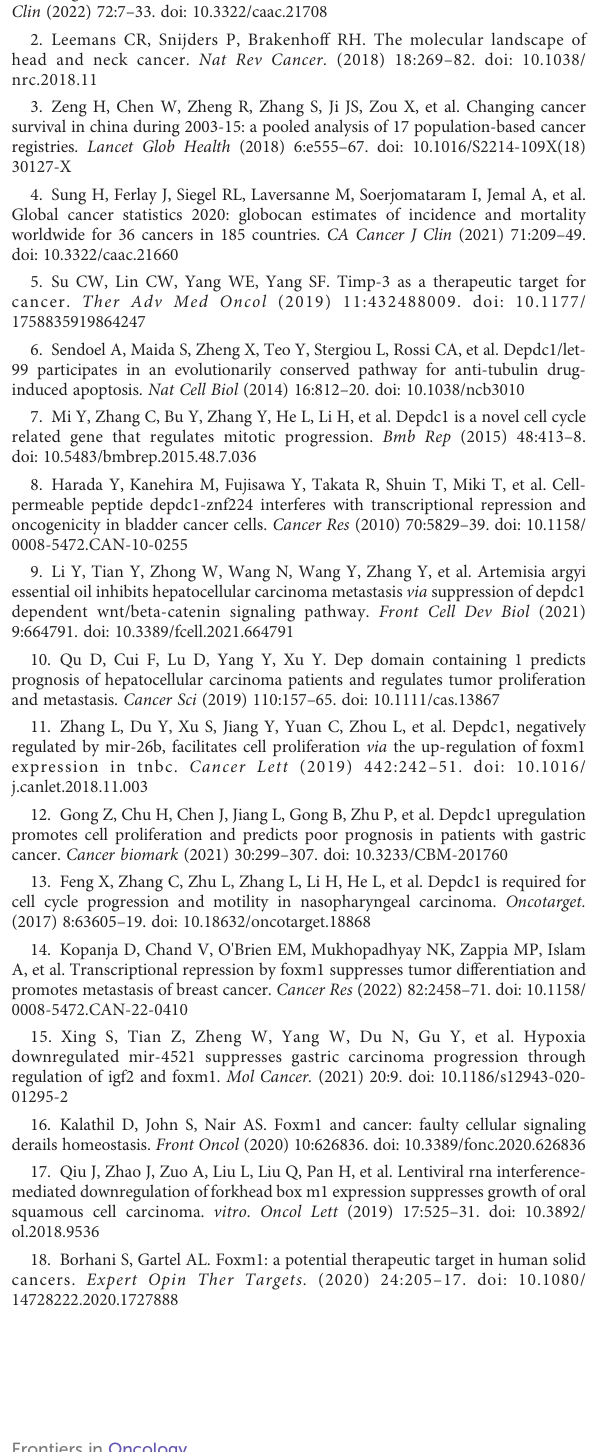
SUPPLEMENTARY FIGURE 3 Identi fi cation of the DEPDC1 interacting proteins. (A) The FOXM1 protein expression correlated with DEPDC1 by Pearson correlation coef fi cient (PCC) analysis. (B) The intracellular location of DEPDC1 and FOXM1 was shown on the GeneCards website. (C) Construction map of FOXM1-Flag and DEPDC1-V5